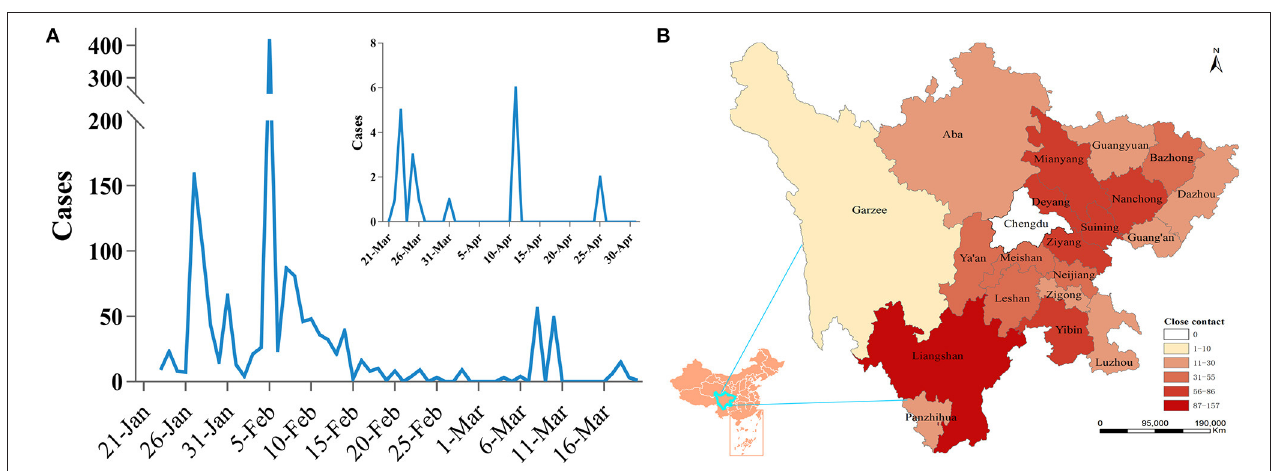
FIGURE 2 | The distribution characteristics of close contacts. (A) Time distribution of close contacts. (B) Spatial distribution of close contacts.